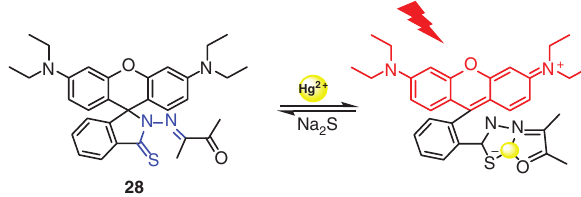
Figure 18: Recognition mechanism of probe 28 with Hg 2 + .